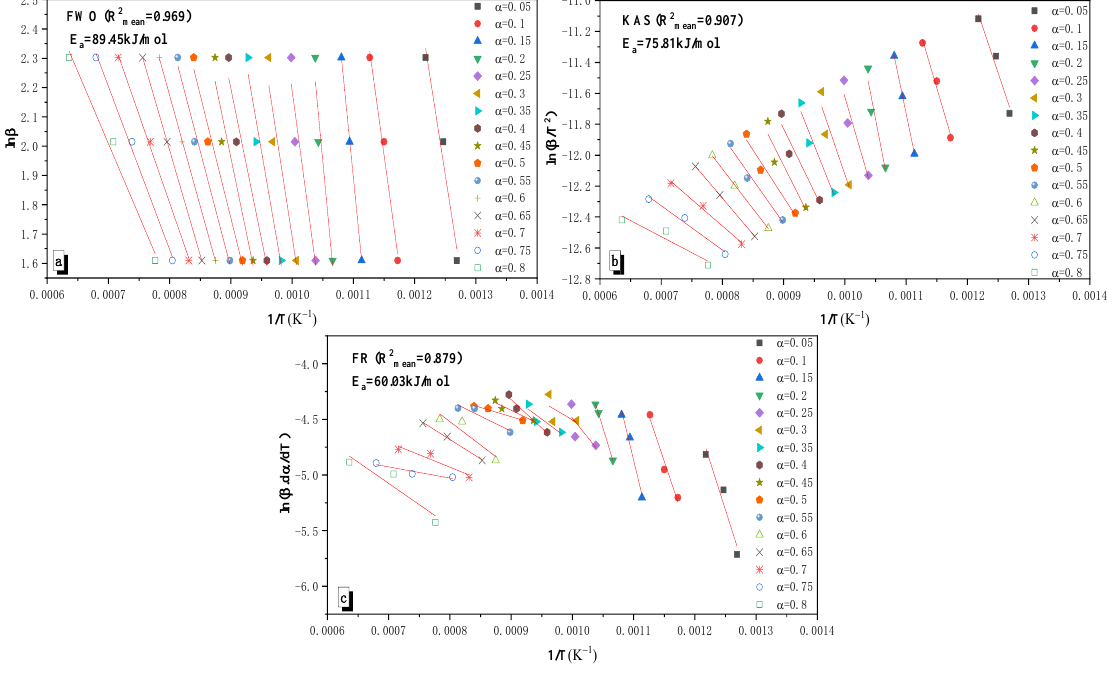
Figure 6. ( a ) FWO, ( b ) KAS, and ( c ) FR graphs for non-isothermal reduction of iron ore. Table 5. Kinetic parameters of sinter reduction,